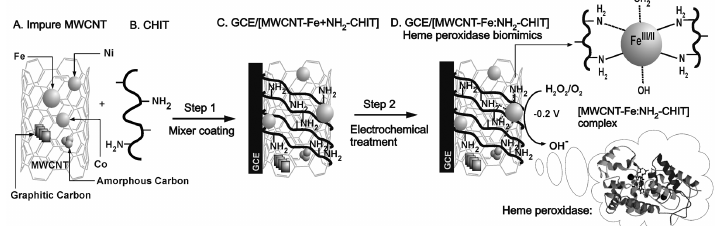
Figure 10. Schematic representation ( A – D ), of the construction of a chemically modified vitreous car- bon electrode biosensor of impure multi-walled carbon nanotubes (MWCNT-Fe)-chitosan biopolymer (H 2 N-CHIT) (GCE/[MWCNT-Fe:H 2 N-CHIT]) for the electrocatalytic and electrochemical